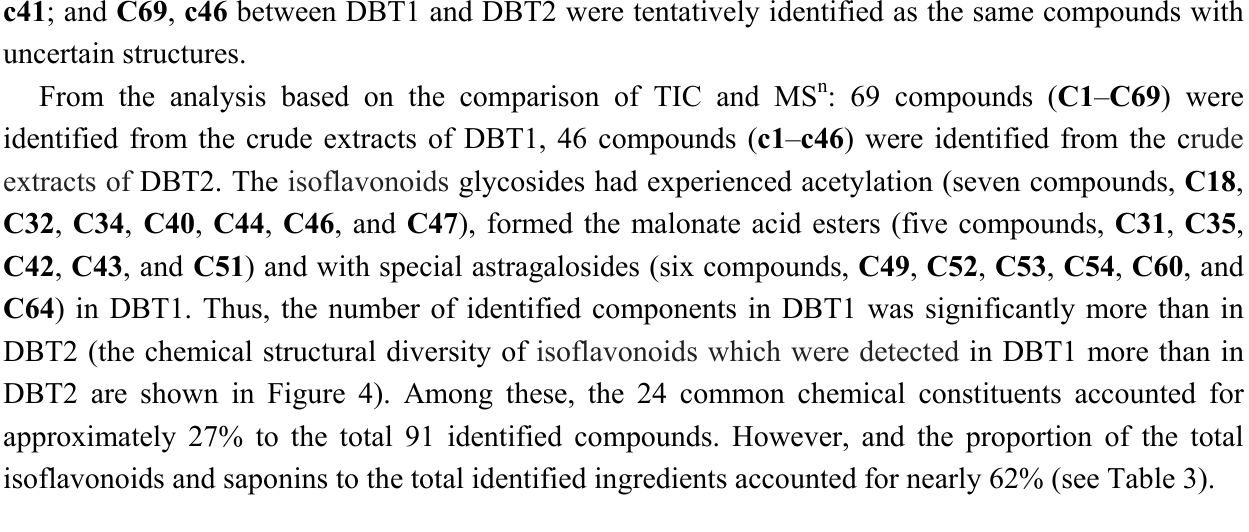
Figure 4. The chemical structures of the main proposed different isoflavonoids in Danggui Buxue Tang 1 more than Danggui Buxue Tang